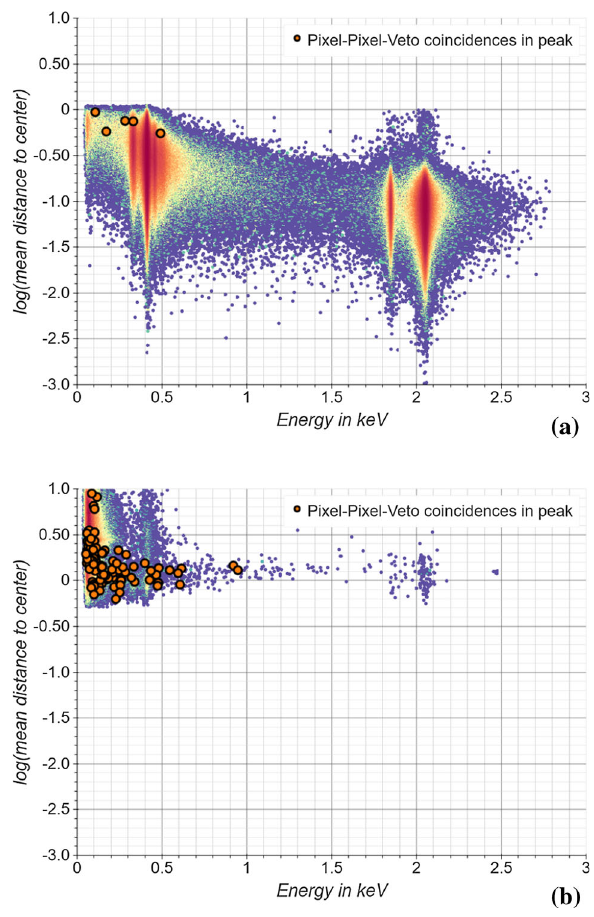
Fig. 13 The logarithm of the mean distance to the ellipses’ centers against E Filter . a Only pulses, which are located in all three ellipses are shown. The band around distance ≈ 1 with the substrate events inside disappeared. Mainly the pulses due to the EC in 163 Ho remain. b Events, which are at least not located in one of the three ellipses are shown. Mainly the band around distance ≈ 1 remains, which